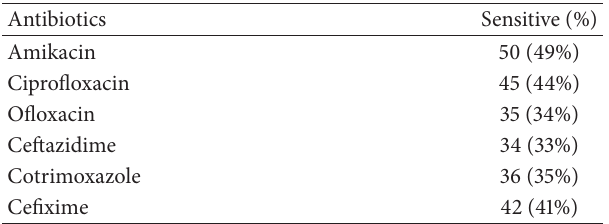
Table 3: Antibiotic susceptibility patterns of Gram-negative bacilli.